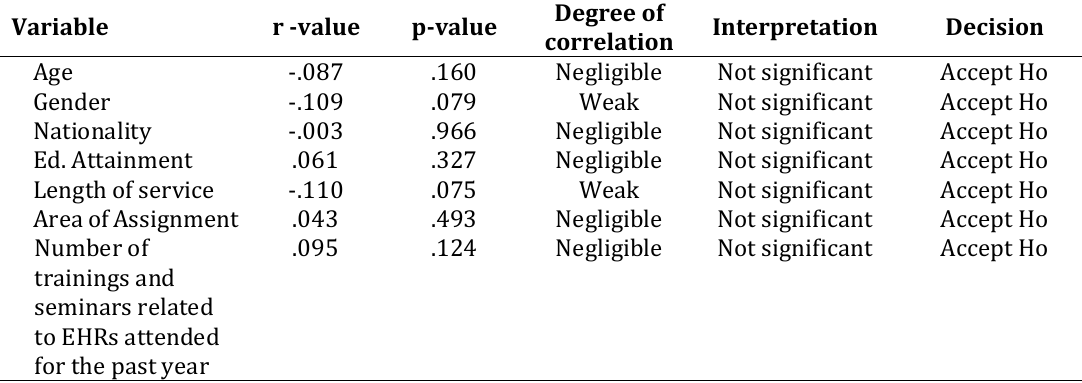
Table 5 Relationship between profile variables and knowledge of nurses in using EHR Variable